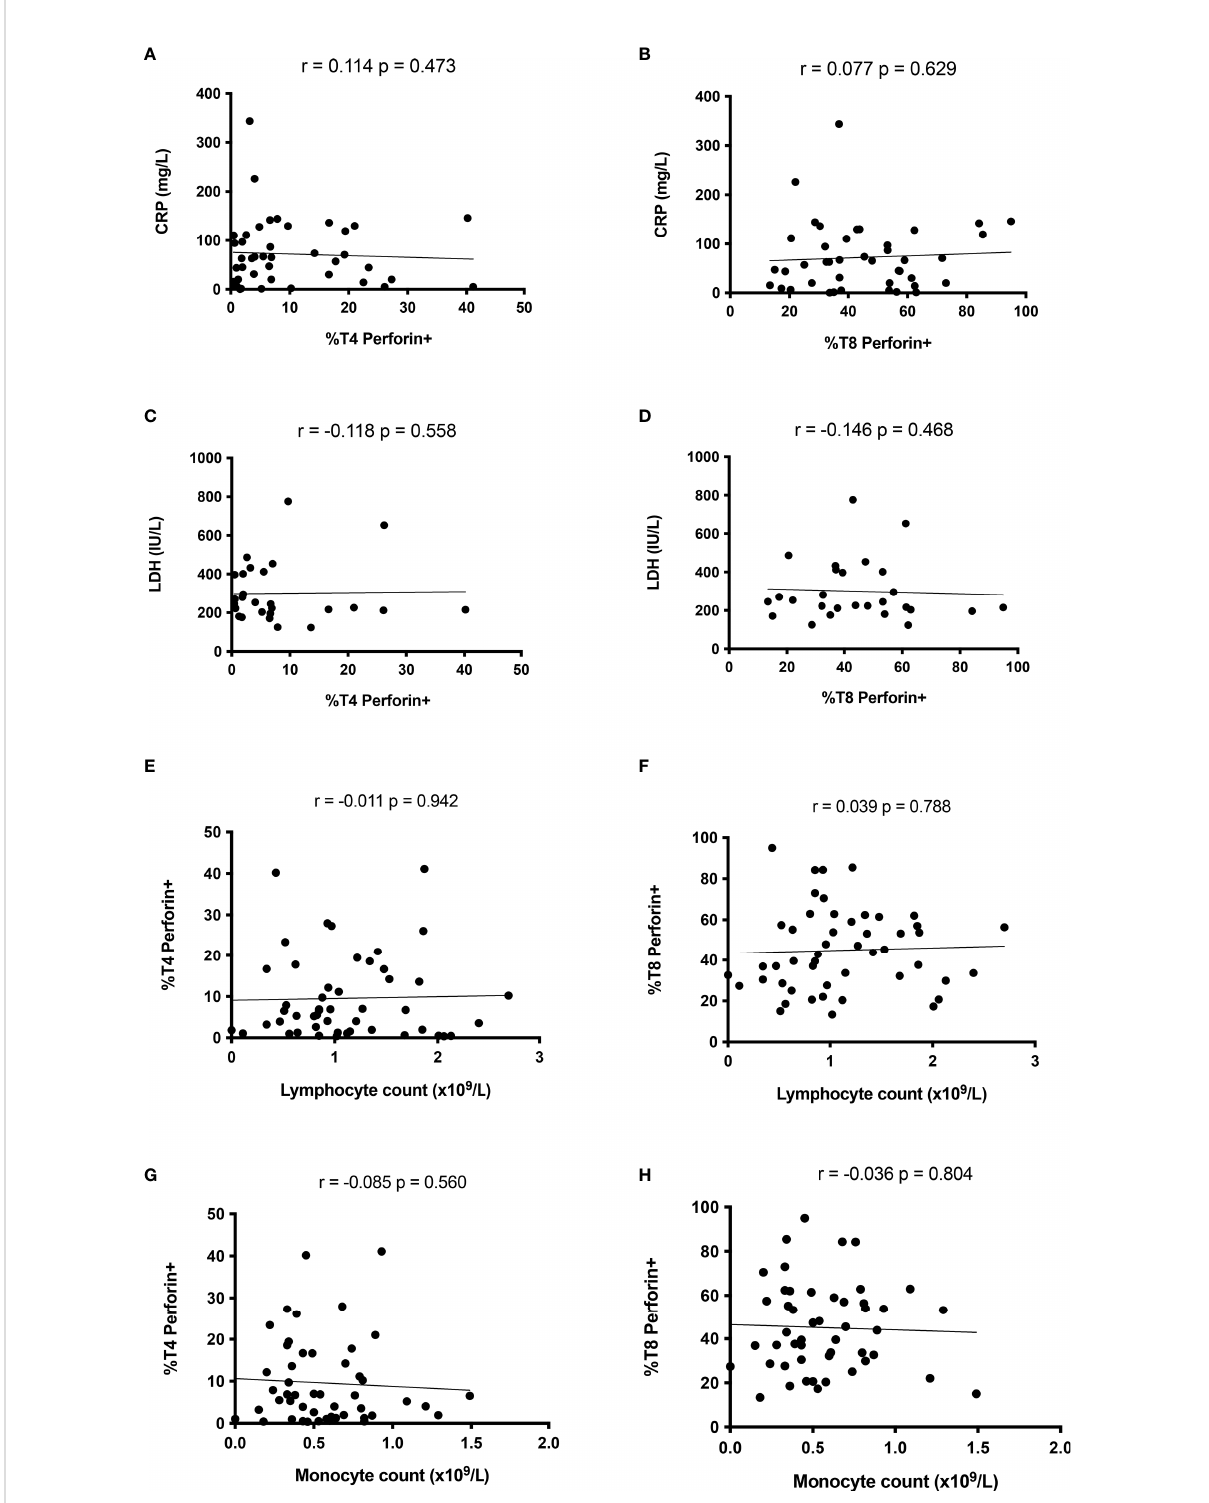
FIGURE 3 Perforin expression in T cells is not linked to disease severity during the acute phase of SARS-CoV-2 infection. Absence of correlation between perforin expression in CD4+ lymphocytes and CRP (A) , LDH (C) , lymphocyte (E) and monocyte (G) counts. Perforin expression in CD8+ lymphocyte is linked neither to CRP (B) , LDH (D) nor to lymphocyte (F) or monocyte (H)